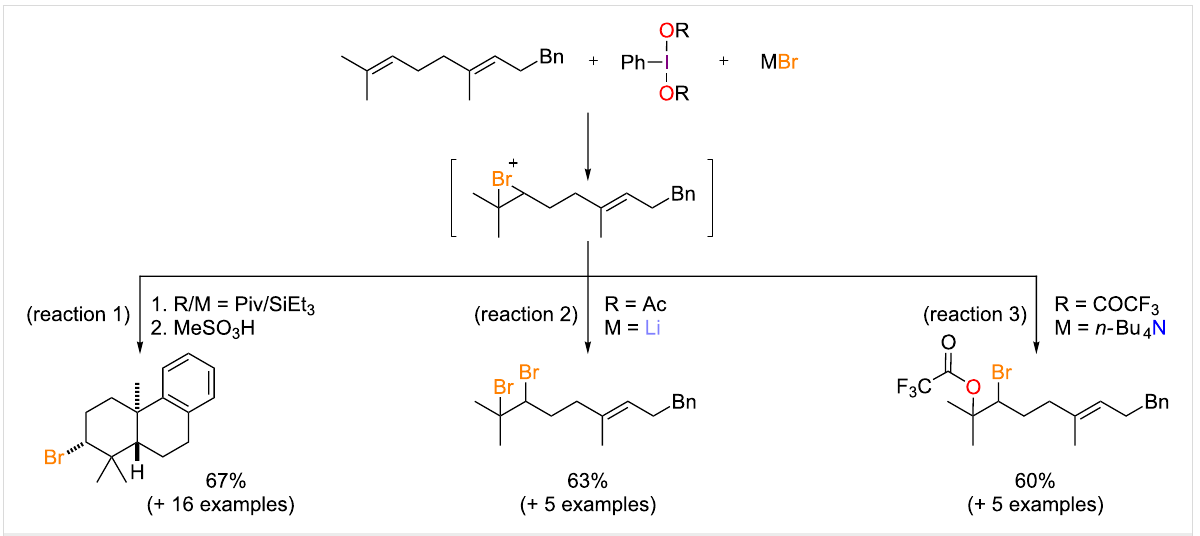
derivatives using a combination of iodine(III) oxidant and a bromide source. In this fashion, the reaction of homogeranyl- benzene with bis( tert -butylcarbonyloxy)iodobenzene and triethylsilyl bromide, followed by acidic treatment led to a tricyclic brominated adduct (Scheme 1, reaction 1). Yet in the course of our study we also showed that the reactivity of the key bridged bromonium intermediate could also be steered towards non-cyclizing vicinal difunctionalizations using slightly differ- ent combinations of a (diacyloxyiodo)arene and a bromide salt. Indeed, (diacetoxy)iodobenzene (DIB) and lithium bromide yield a dibromo adduct (Scheme 1, reaction 2), whereas a combination of (bis(trifluoroacetoxy)iodo)benzene (PIFA) and tetra- n -butylammonium bromide (TBAB) gives bromo(trifluoro)acetoxylated 3a (Scheme 1, reaction 3) [16]. We then decided to further explore the synthetic potential of the latter two vicinal difunctionalizations of terpenoids by not only expanding their substrate scope but also by trying to achieve other bromo-oxylations as well as analogous chloro-